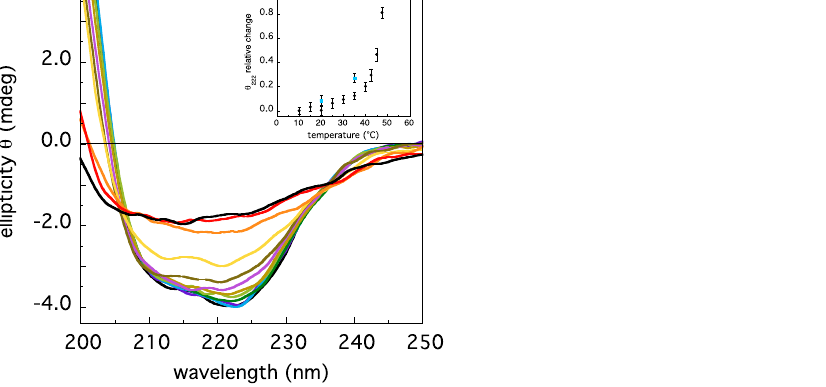
Figure 3. Circular dichroism spectra at different temperatures (10 ◦ C, black; 15 ◦ C, purple; 20 ◦ C, cyan; 25 ◦ C, dark green; 30 ◦ C, light green; 35 ◦ C, light brown; 40 ◦ C, light purple; 42.5 ◦ C, dark brown; 45 ◦ C, yellow; 47.5 ◦ C, orange; 50 ◦ C, red; 55 ◦ C, black), at the protein (monomers) concentration of 2 µ M. In the inset, the relative change in the ellipticity at 222 nm is reported. The filled circles in cyan correspond to the ellipticity measured for a sample ten times less concentrated (0.2 µ